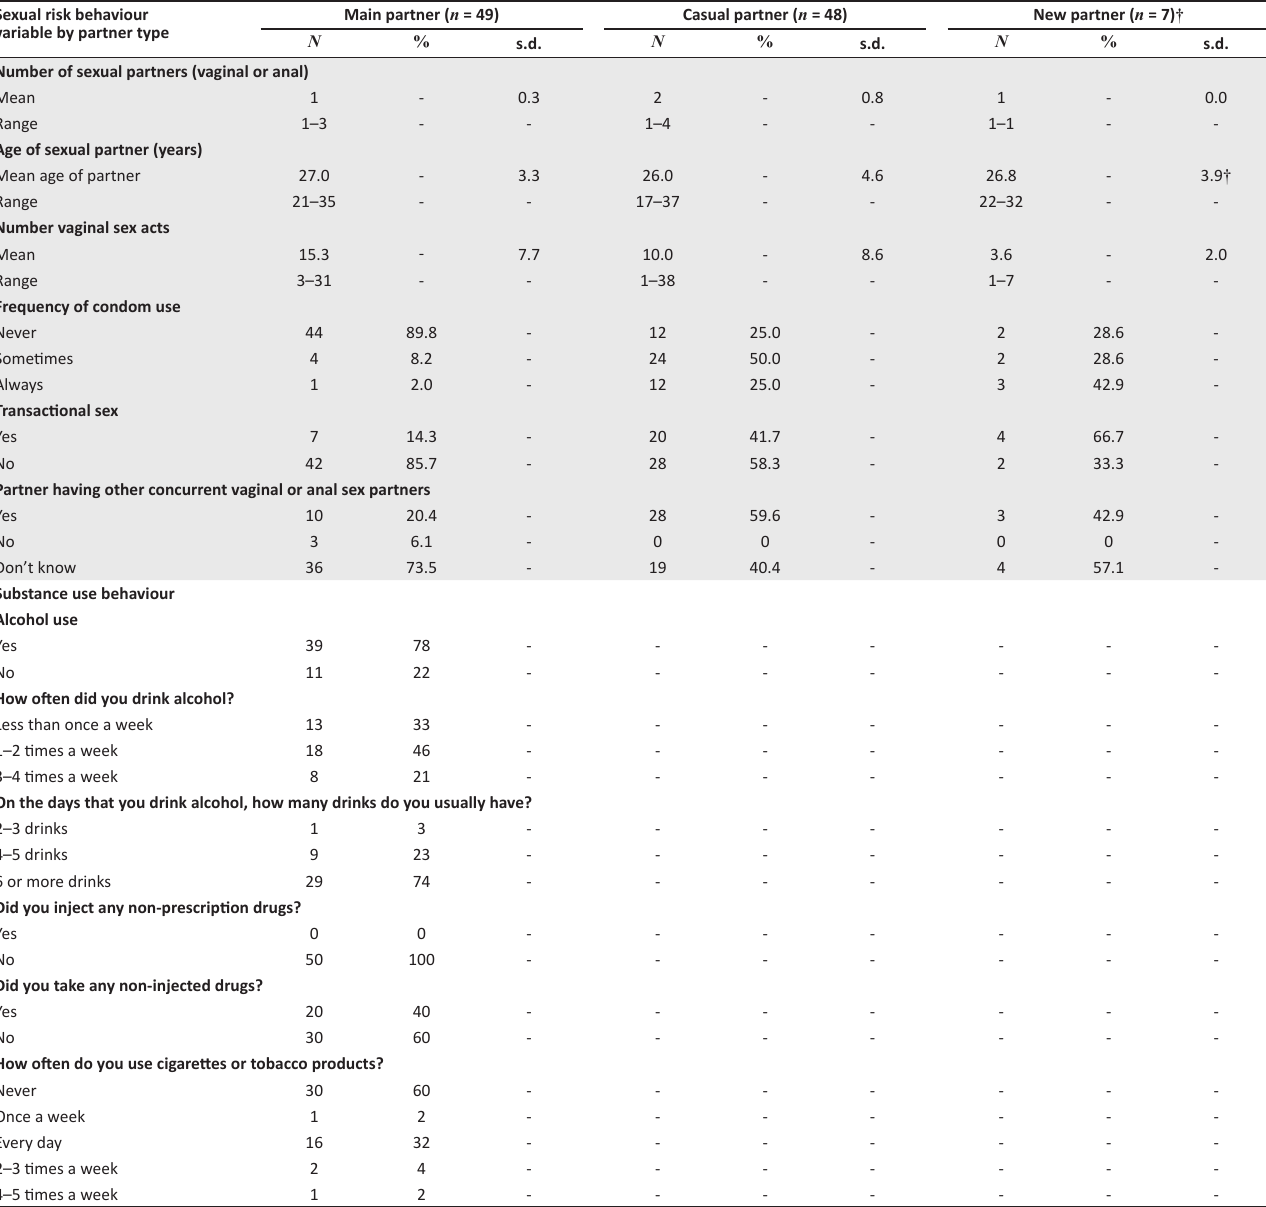
TABLE 1: Screening sexual risk and substance use behaviours (in the last 30 days).